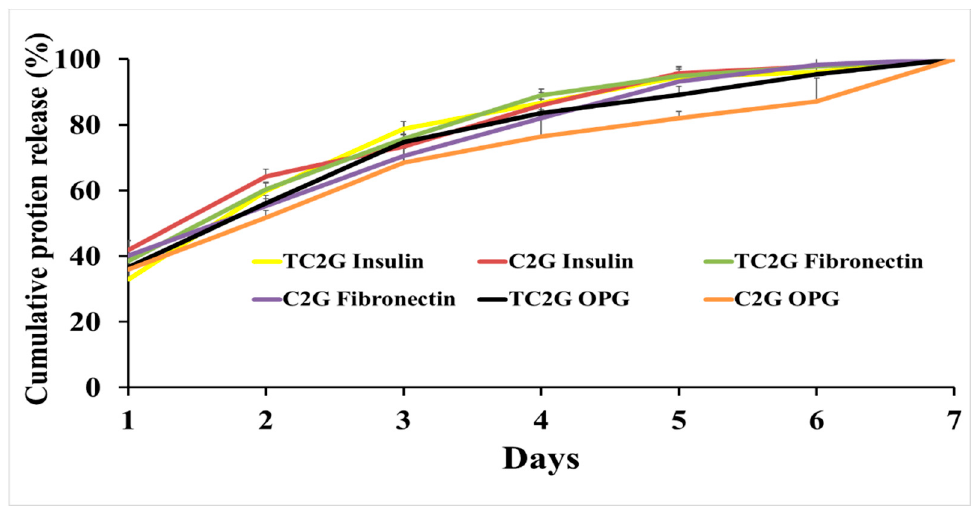
Figure 5. In vitro release of human insulin, fibronectin and OPG from C 2 G and TC 2 G over a 7-day period. The total protein loading in hydrogels was released in the first week. Triplicates for each hydrogel were analysed and means are shown.